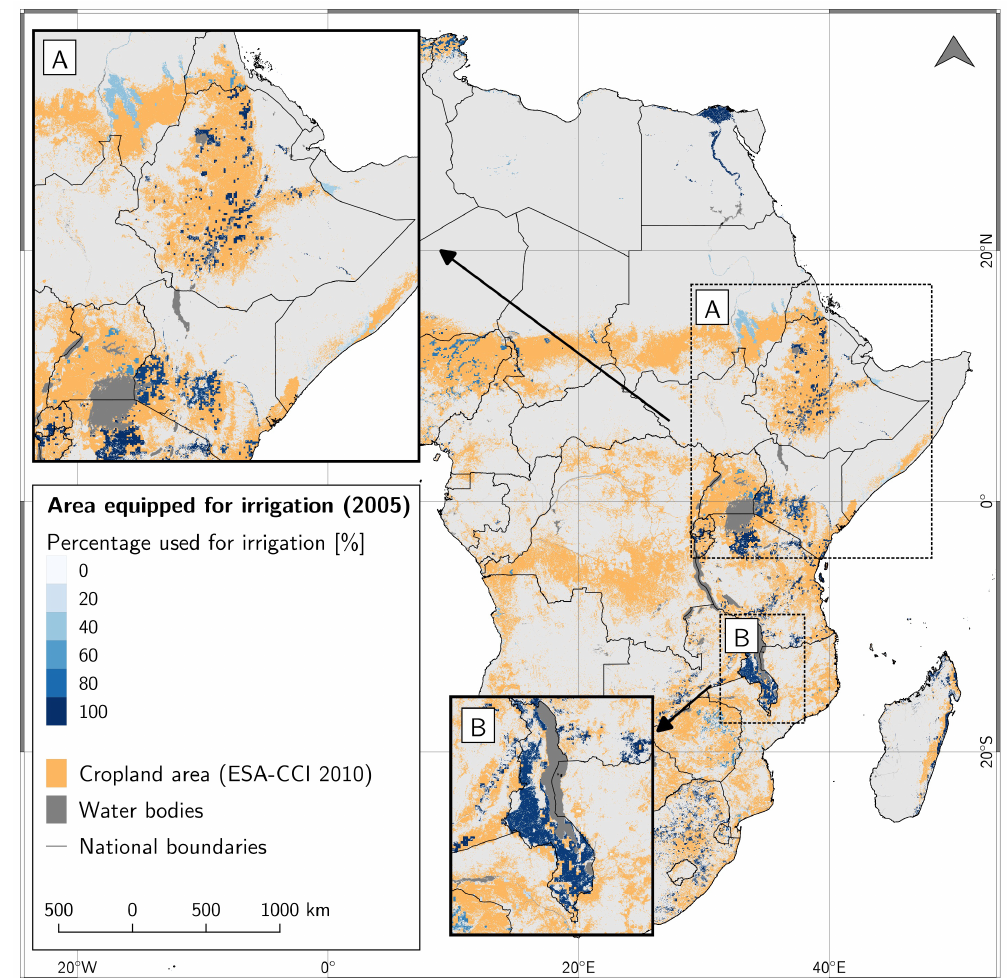
Figure 13. Area of irrigation for selected regions, A: Eastern Africa, B: Malawi (Data: